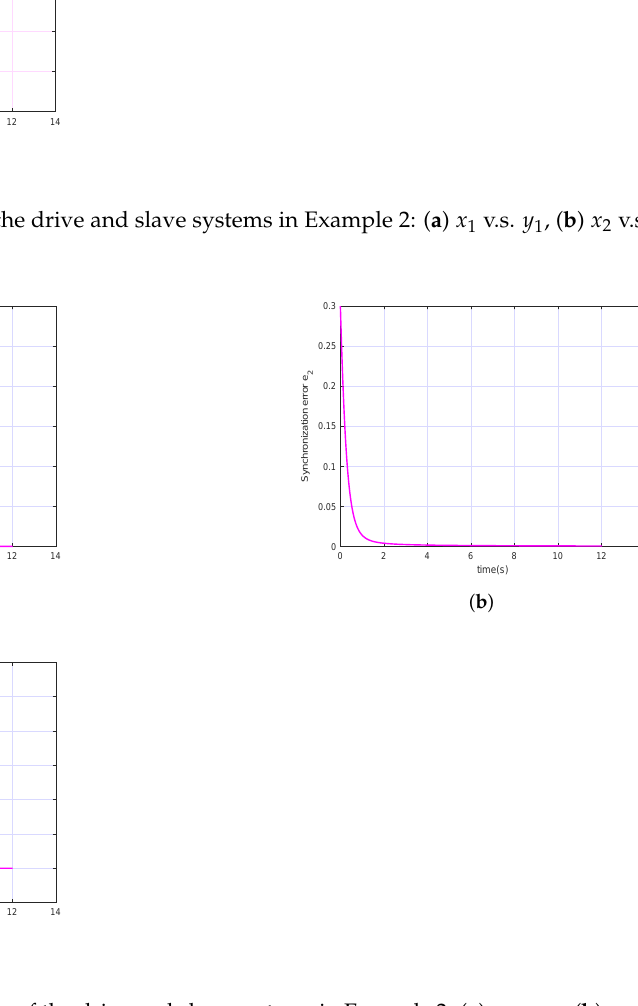
Figure 6. Synchronization error of the drive and slave systems in Example 2: ( a ) x 1 − y 1 , ( b ) x 2 − y 2 , ( c ) x 3 − y 3